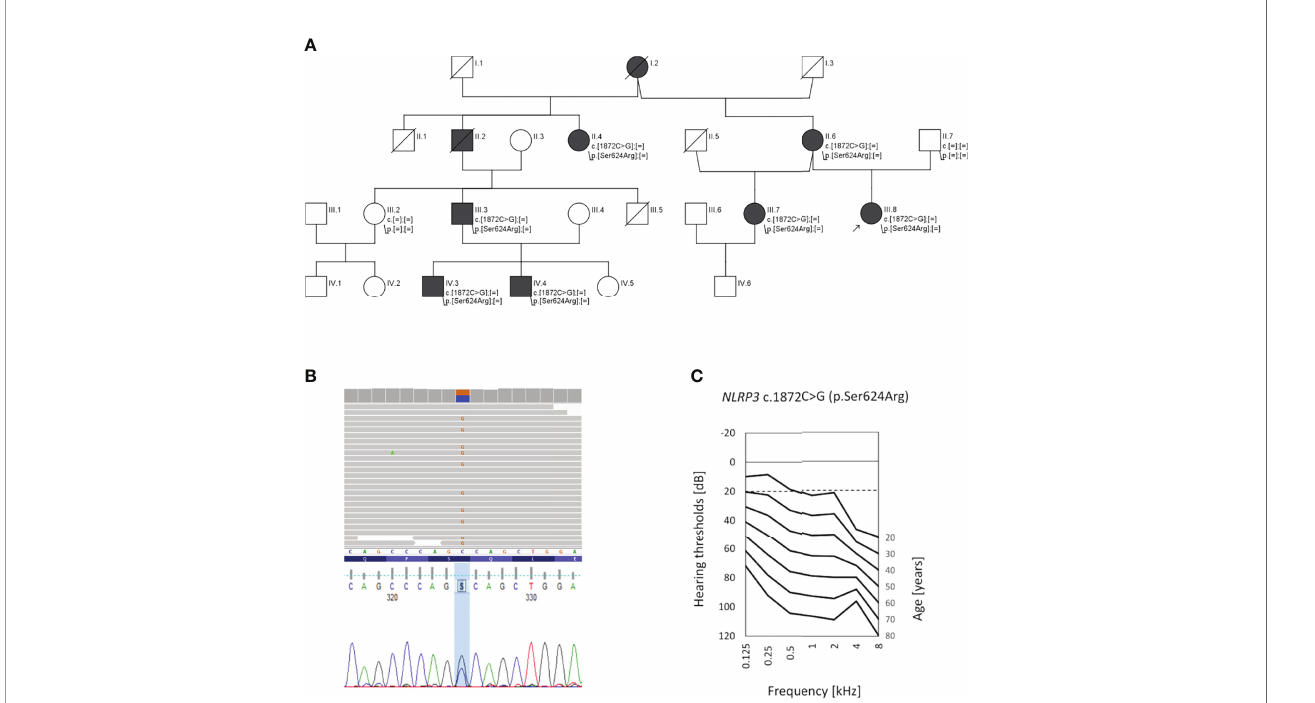
FIGURE 1 | Pedigree of the investigated family, genetic data, and audiological characteristics. (A) Pedigree showing autosomal dominant hearing loss (black symbols); healthy individuals are shown in white. The proband (III.8) is indicated by an arrow. (B) Results of next-generation sequencing and Sanger sequencing showing the c.1872C>G transversion (p.Ser624Arg) in the NLRP3 gene. (C) Age-related typical audiogram (ARTA) based on audiological data of the 5 patients with NLRP3 p.Ser624Arg as the likely pathogenic variant. The normal hearing threshold is marked with a detached